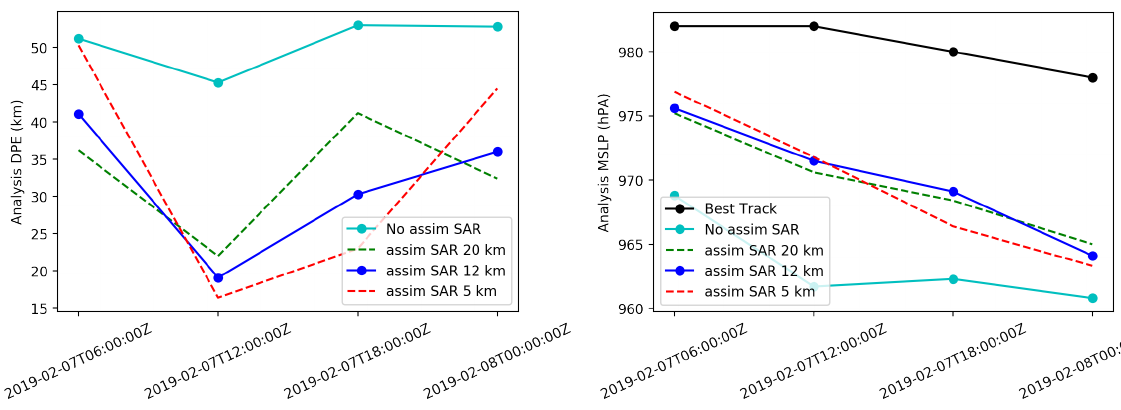
Figure 16. Evolution of DPE ( left ) and MSLP ( right ) in analyses of 7 February 2019 06:00,12:00, 18:00Z and 8 February 2019 00:00Z for NO_SAR, SAR_12km_2ms,